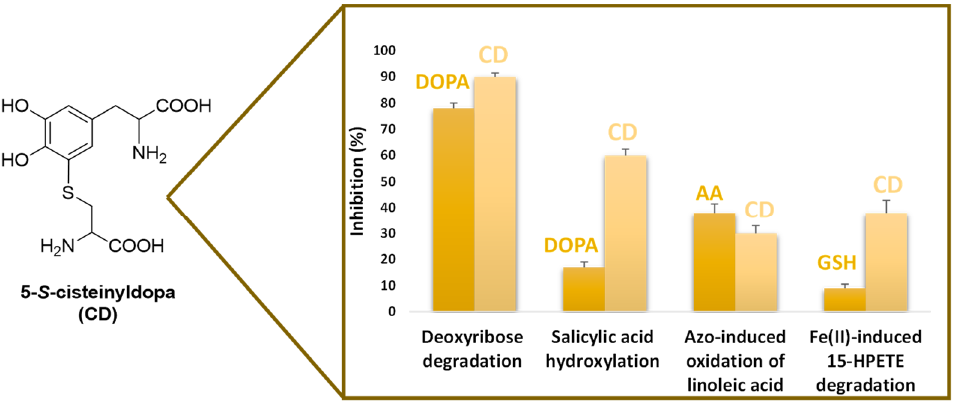
Figure 6. Effect of 5- S -cysteinyldopa (CD) on: deoxyribose degradation and salicylic acid hydroxylation induced by the Fenton reagent; conjugated diene formation in the 2,2′-azobis (2- amidinopropane) (ABAP)-induced oxidation of linoleic acid and malondialdehyde formation from Fe 2+ -induced 15-HPETE degradation. For comparative purposes the effects of DOPA, ascorbic acid (AA) and GSH were examined at the same concentration.